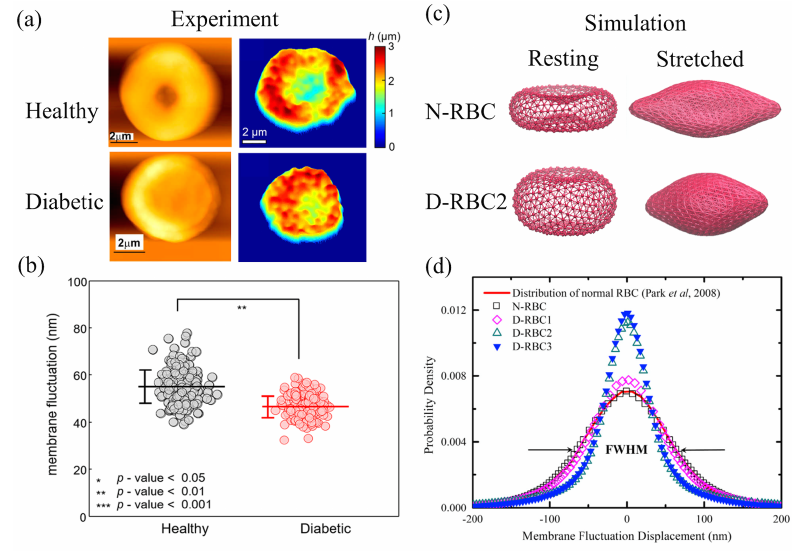
Figure 9. ( a ) Morphological characteristics of a representative healthy red blood cell (RBC) and a diabetic RBC depicted in the AFM images ( left ). Reproduced from reference [150] with permission. Two-dimensional topographic height maps ( right ). Reproduced from reference [151] with permission. ( b ) Scatter plot of retrieved membrane fluctuations from RBC data in healthy and diabetic groups where the horizontal lines are the mean values of membrane fluctuations and the vertical error bars are the sample standard deviations. Reproduced from reference [151] with permission. ( c ) Coarse-grained models of RBCs in healthy (N-RBC) and in diabetic (D-RBC3) patients with their resting forms ( left ) and the stretched states under external tensile force 100 pN ( right ). Reproduced from reference [152] with permission. ( d ) Membrane fluctuation distributions of different RBC models [152]. N-RBC is a representative model for normal RBCs, while D-RBC1, D-RBC2, and D-RBC3 are three potential models for diabetes mellitus (DM) RBCs. The simulation results of N-RBC is compared with the experimental data [153] drawn in red line and FWHM is the full-width half-maximum. Reproduced from reference [152] with